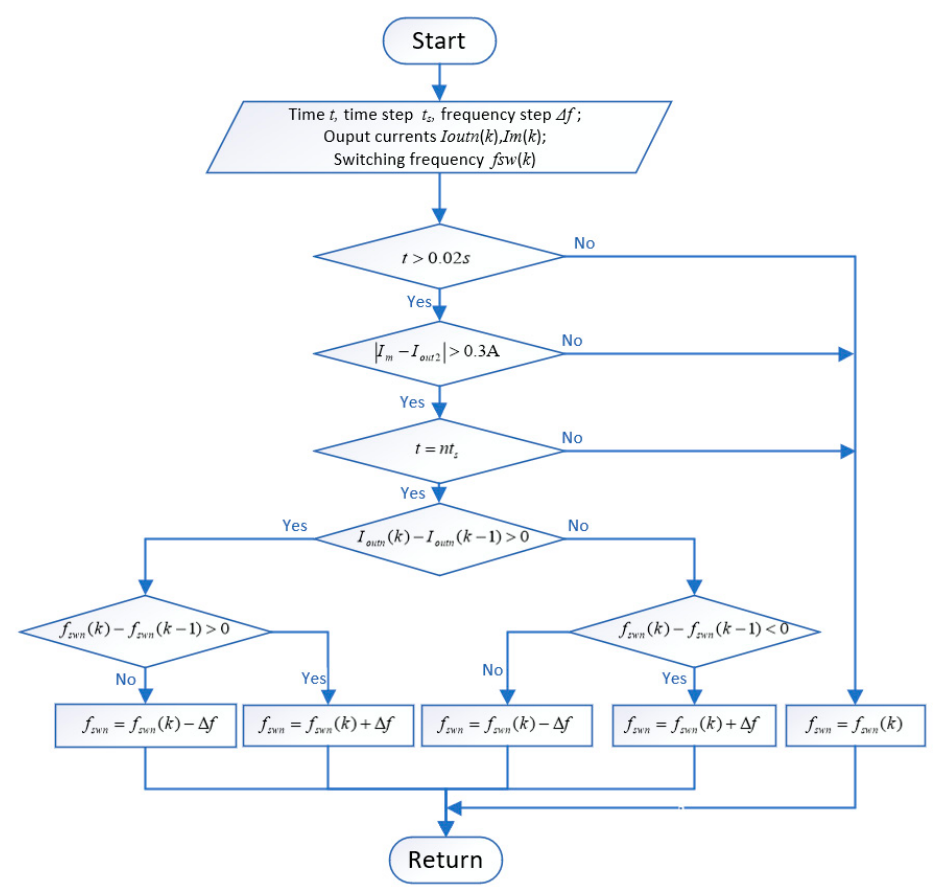
Figure 8. Algorithm depicting output current balancing control of the paralleled DC transformer circuits (DCXs).